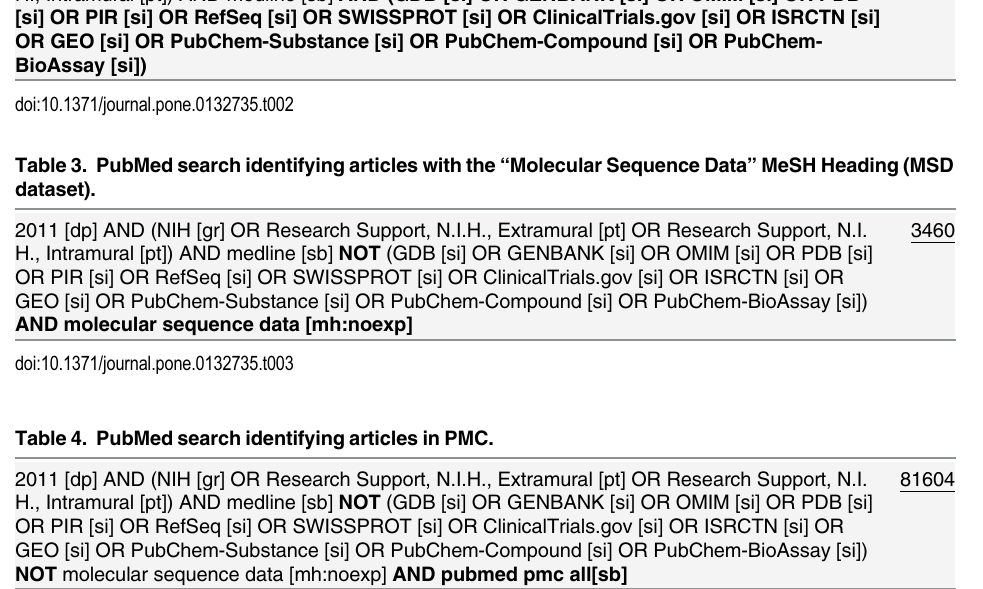
Table 2. PubMed searches identifying when datasets were deposited in certain repositories (SI dataset). 2011 [dp] AND (NIH [gr] OR Research Support, N.I.H., Extramural [pt] OR Research Support, N.I. H., Intramural [pt]) AND medline [sb] AND (GDB [si] OR GENBANK [si] OR OMIM [si] OR PDB